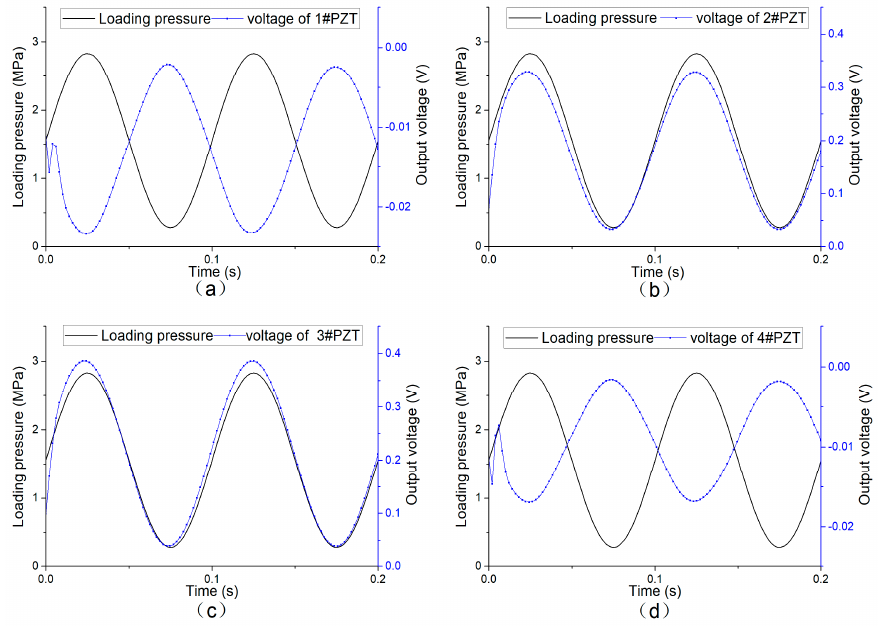
Figure 18. Simulated voltage output of each piezoelectric unit under sinusoidal loading. ( a ) output of 1#PZT; ( b ) output of 2#PZT; ( c ) output of 3#PZT; ( d ) output of 4#PZT.